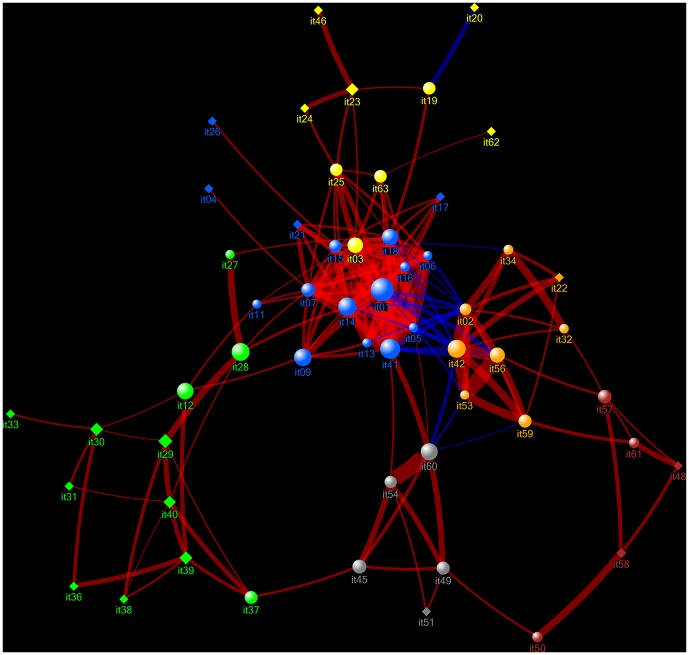
The Psychopathology Web.Network graph of the correlational relationships between 55 items (symptoms) of the CPRS, which form a 6-cluster structure. Node  =  CPRS item (symptom), link  =  significant correlation. The threshold for the significance of network links has been optimized using the procedure described above. Red links: positive correlations. Blue links: negative correlations. The thickness of the links reflects the strength of their corresponding correlation coefficient (weight). It01 etc: item number of the CPRS. Nodes are positioned according to the Hagel-Koren Fast Multiscale layout algorithm. The color of the nodes shows their network cluster membership. Yellow: ANXIETY, Light Blue: DEPRESSION. Orange: MANIA, Green: PSYCHOSIS, Grey: RETARDATION, Brown: BEHAVIORAL DISORGANIZATION. NCD and PCA differ with respect to the placement of items 03, 04, 25, 27, and 28. These mismatches occur at the boundaries between the DEPRESSION cluster and the PSYCHOSIS cluster, and between the DEPRESSION cluster and the ANXIETY cluster and can be interpreted as ‘border disputes’ between NCD and PCA. Spheres: bridge symptoms. Closed diamonds: core symptoms. Node size denotes betweenness centrality score of the node (a measure of its involvement in connecting the various parts of the Psychopathology Web through shortest paths). Smaller and larger loops can be observed that run within and between the various network clusters. See text for further details.